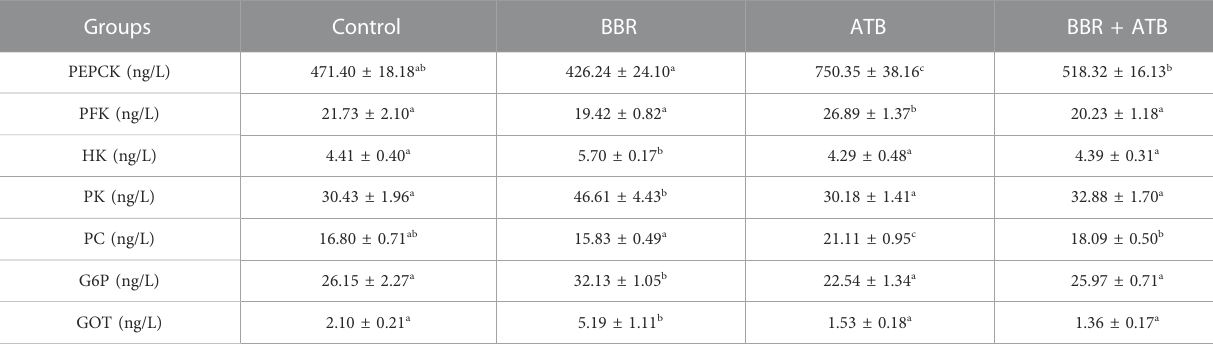
TABLE 4 Activities of metabolism-related enzymes in the liver of largemouth bass. Groups